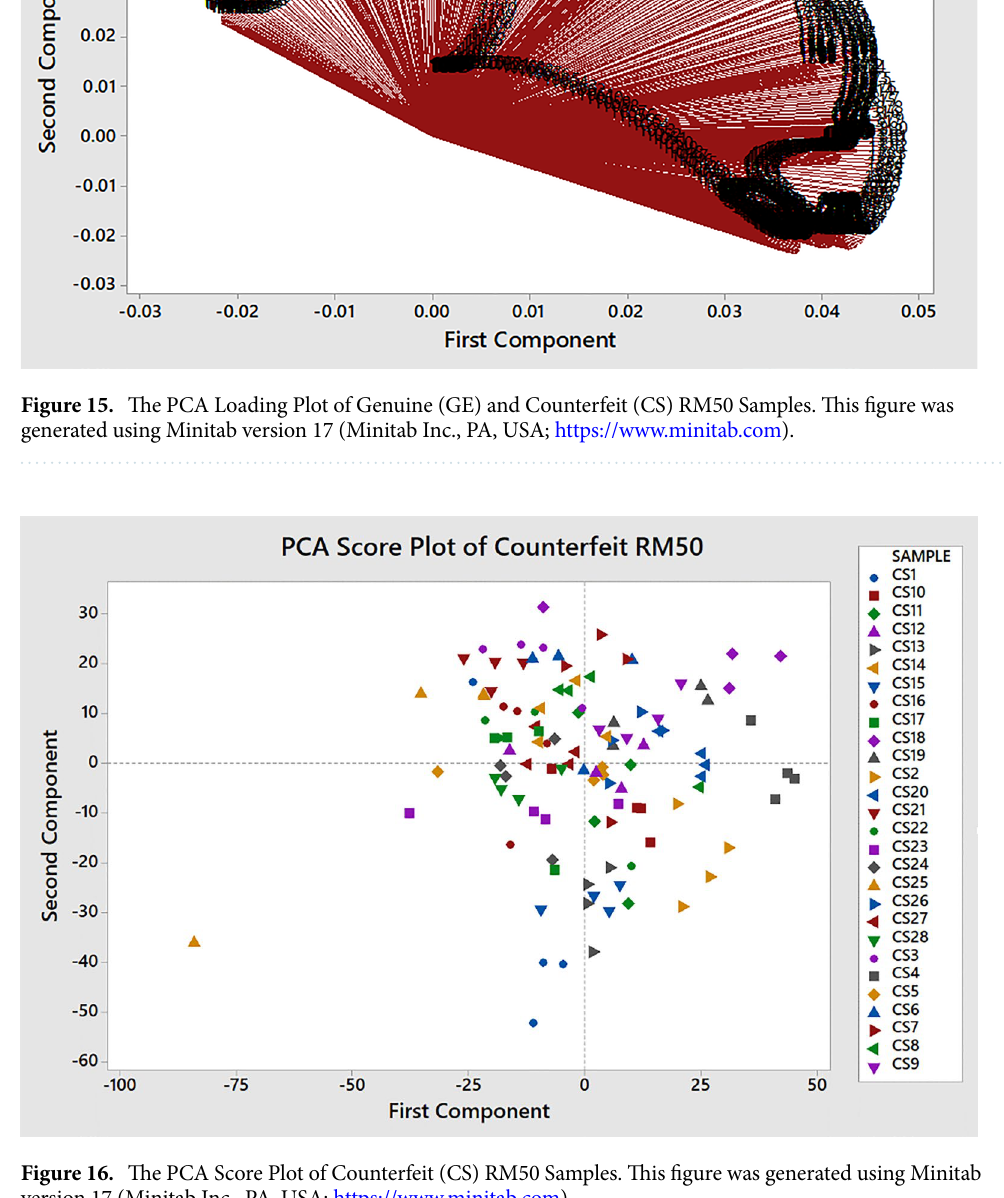
Figure 16. The PCA Score Plot of Counterfeit (CS) RM50 Samples. This figure was generated using Minitab version 17 (Minitab Inc., PA, USA; https:// www. minit ab.